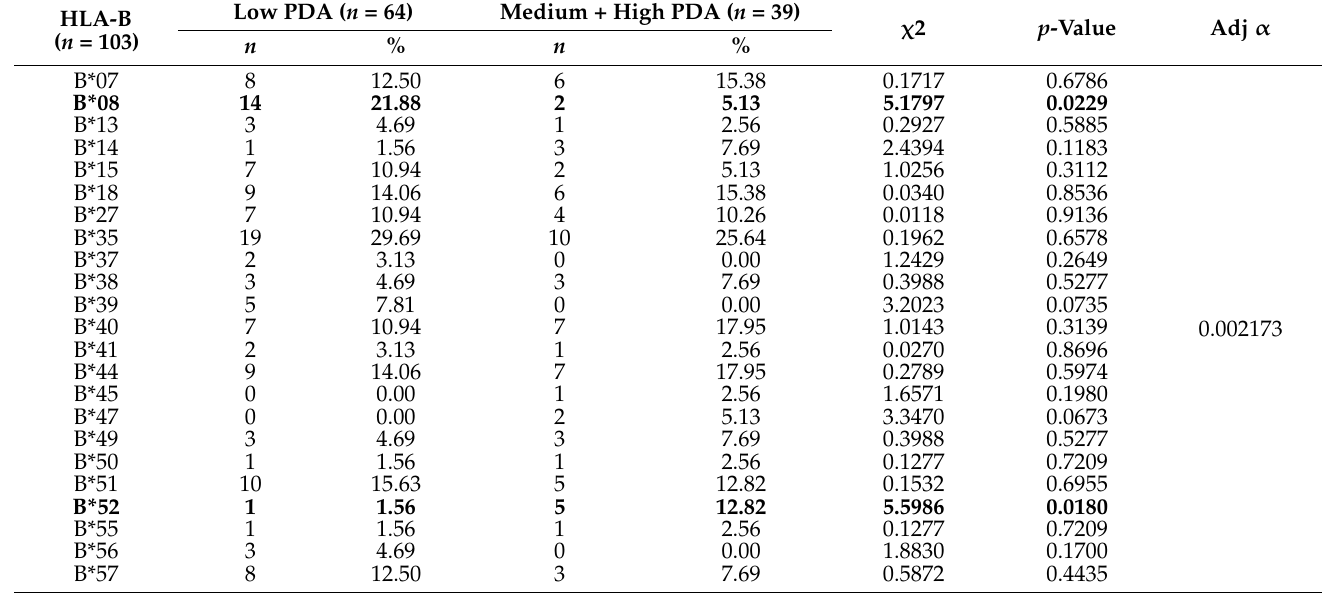
Bold text indicates a statistically significant difference between the two groups. Table 2. Correlation between PDA and